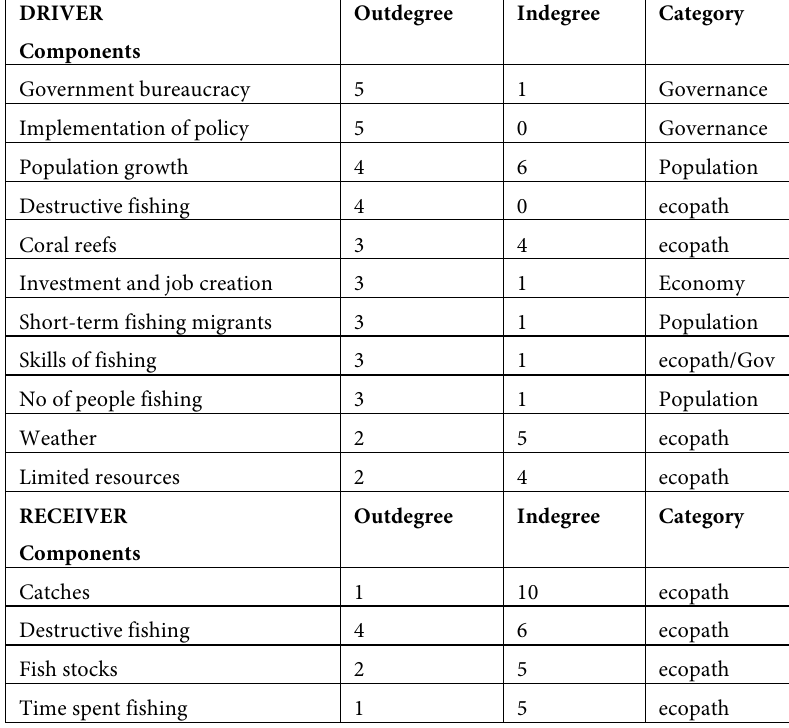
Table S1. Degree analysis of the